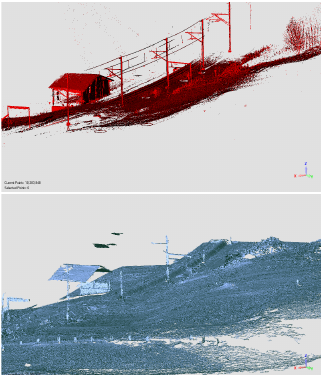
Figure 7: Niederwald - Top: Laser, Bottom: Photogrammetry